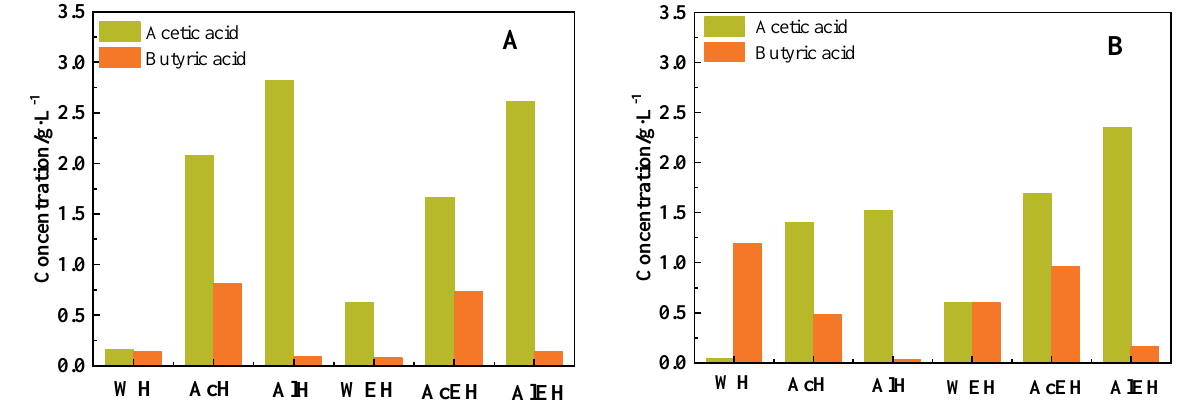
Figure 4. The concentration of acetic acid, butyric acid, and reducing sugar in the hydrolysates. ( A ) CS hydrolysates and ( B ) SS hydrolysates.